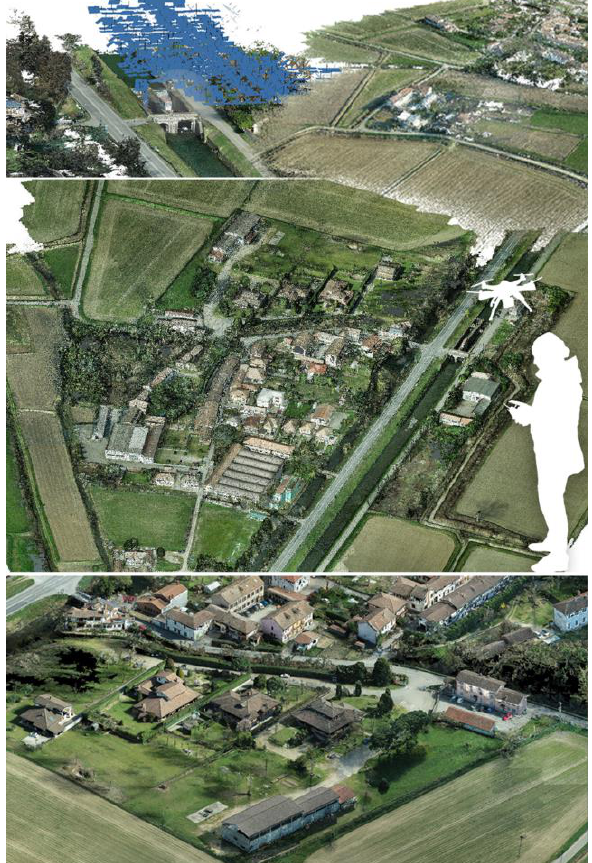
Figure 2 . Geometric and morphological documentation